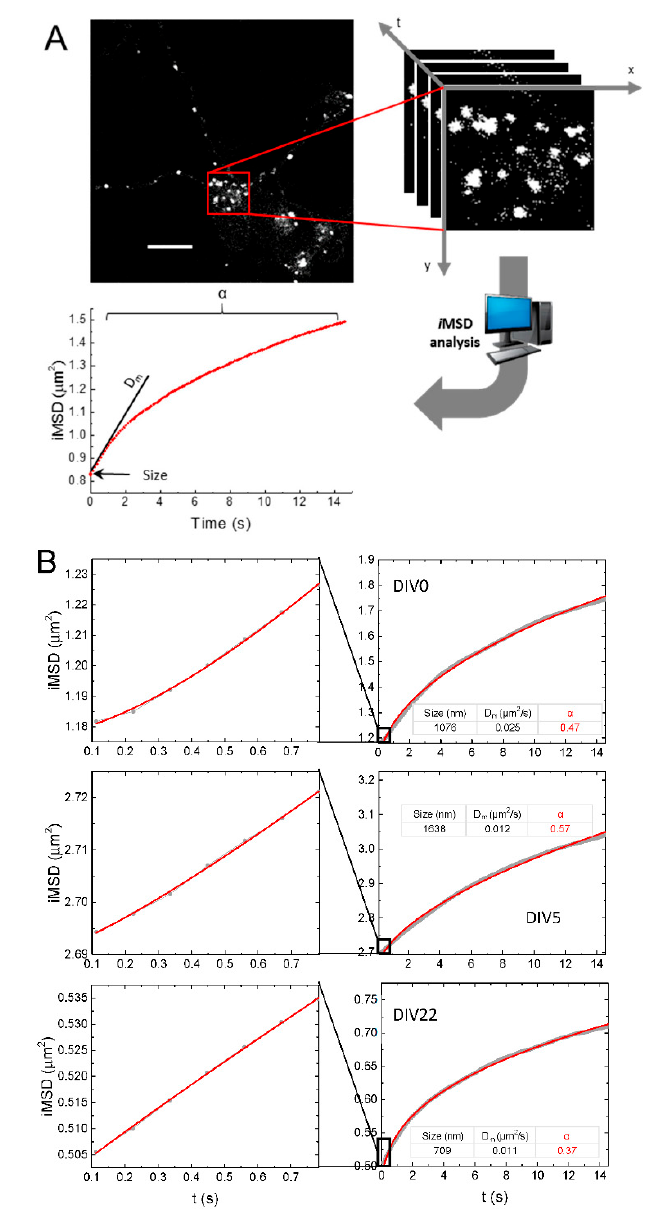
Figure 2. ( A ) i MSD analysis workflow. Top left: confocal fluorescence microscopy image of an NSC shows the distribution of lysosomes labeled with LysoTracker Red. Scale bar, 10 µ m. Top right: a stack of images from a subregion of the image on the left, acquired with temporal resolution of 112 ms. Scale bar: 10 µ m. Bottom: exemplary plot of iMSD (red trace) vs. time of NSC lysosomes populations, with a scheme of how the three output parameters (size, D m , and α ) are determined. ( B ) Gray dots and lines: exemplary iMSD plots obtained from imaging of living cells stained with LysoTracker at DIV0, 5, and 22. Red: fits with a power law with offset. Right: long temporal scale (14.6 s). Left: short temporal scale (0.8 s).